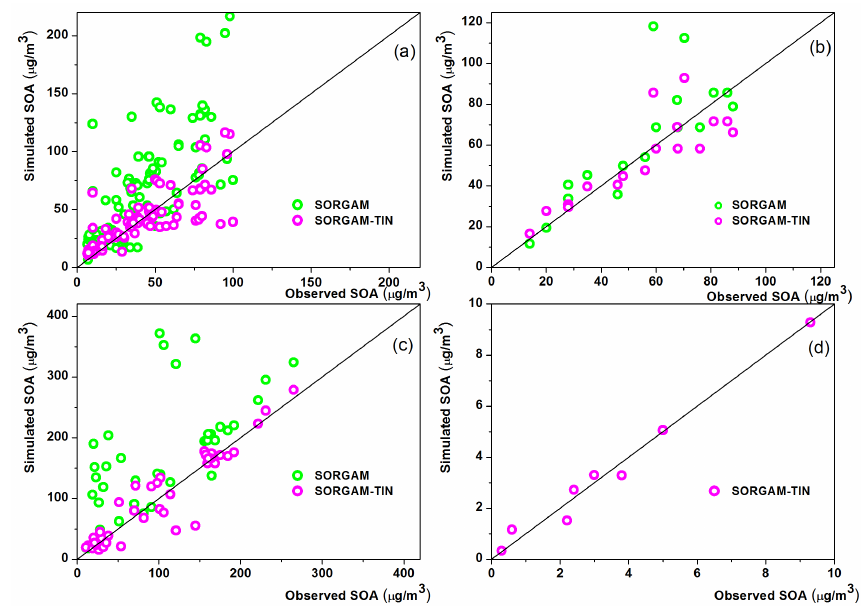
Fig. 4. Comparisons of observed chamber experiment data (x-axis) with original SORGAM (green) and SORGAM-TIN (pink) simulations (y-axis) for (a) α -pinene, (b) limonene, (c) m -xylene, and (d) isoprene.